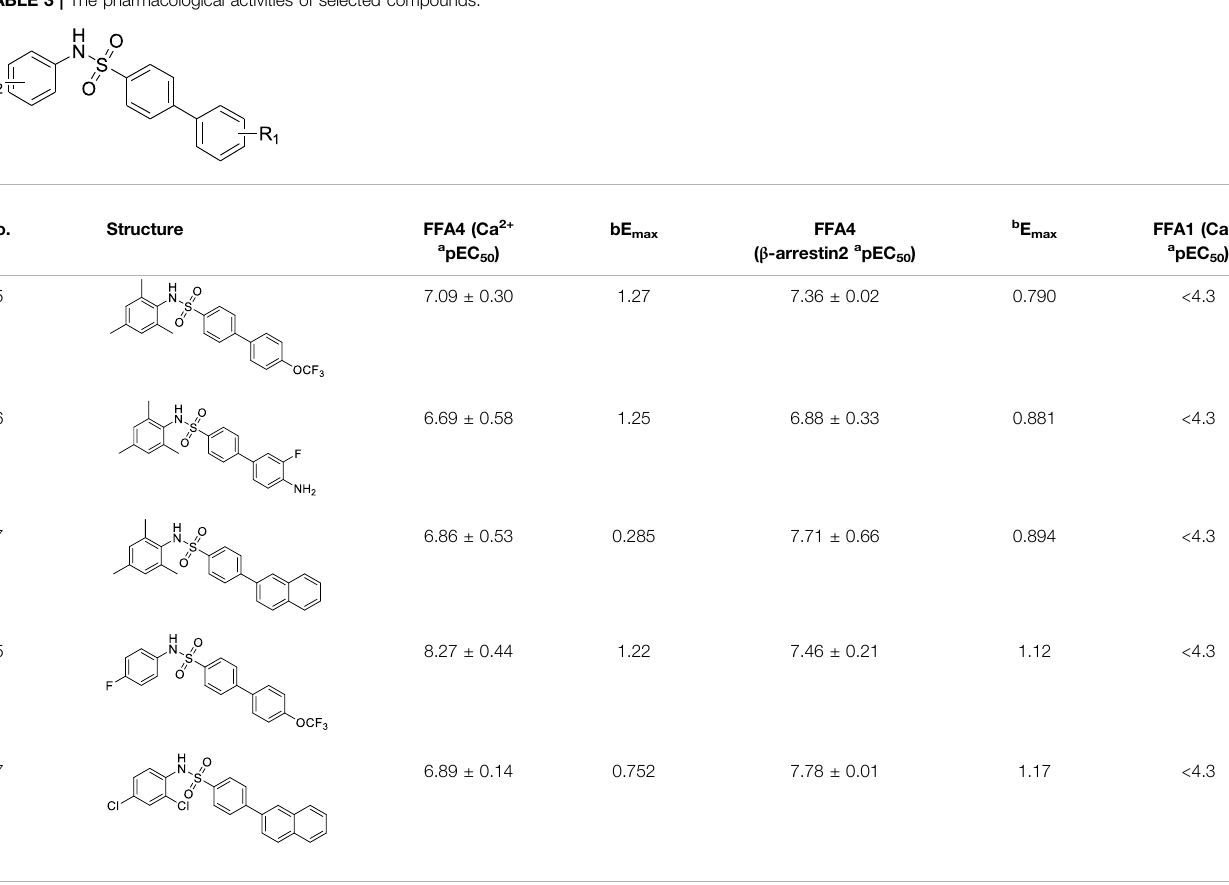
TABLE 3 | The pharmacological activities of selected